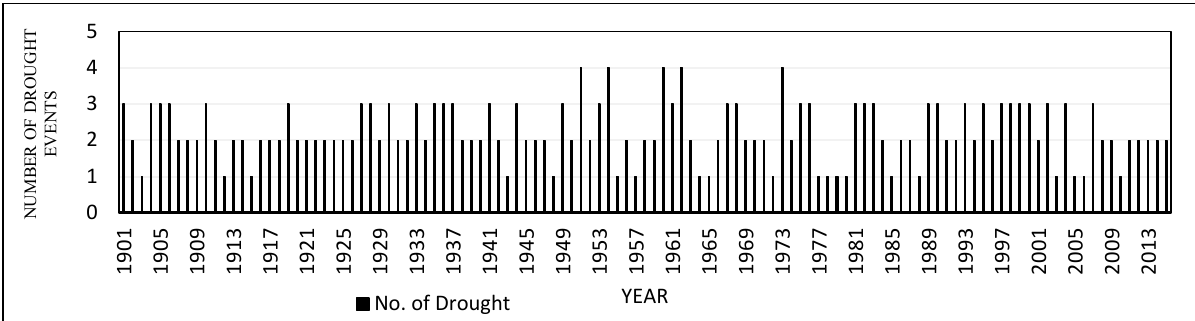
Figure 4.Graph Showing Number of Drought Occurred in Grid Number 166